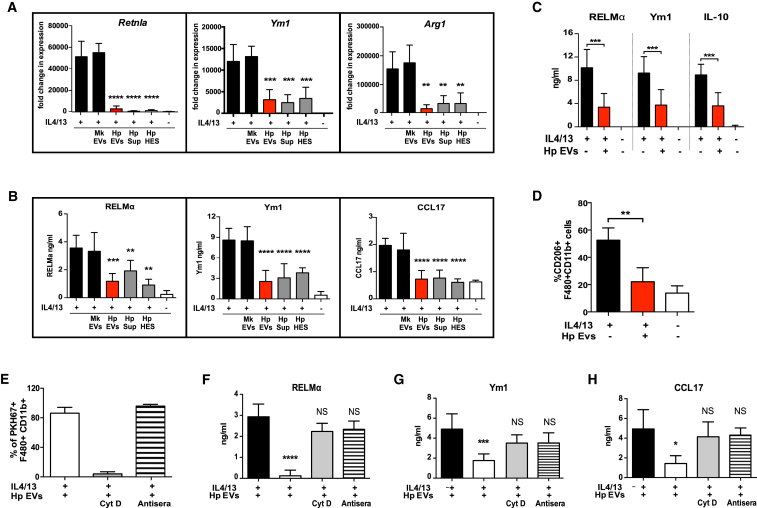
H. polygyrus EVs Suppress the Onset of Alternative Activation in Macrophages(A and B) Relative expression of (A) markers of alternative activation Retnla, Ym1, and Arg1 based on qRT-PCR analysis of extracted RNA or levels of (B) RELMα, Ym1, and CCL17 proteins measured by ELISA from BMDMs treated with 20 ng/mL IL-4/IL-13 ± 5 μg/mL EVs, EV-depleted HES (sup), or total HES (HES) or media alone for 24 hr. As a comparison, cells were incubated with 5 μg/mL EVs derived from MODE-K cells (MK).(C and D) The levels of (C) RELMα, Ym1, and IL-10 by ELISA and expression of (D) CD206 by flow cytometry in BMDMs that were pre-treated with IL-4/IL-13 for 24 hr prior to the addition of 5 μg/mL EVs.(E–H) Percentage uptake of (E) 2.5 μg PHK67-labeled EVs was determined by flow cytometry, and levels of (F) RELMα, (G) Ym1, and (H) CCL17 in the supernatant were assayed from BMDMs co-treated with IL-4/IL-13 and EVs ± 2 μg/mL cytochalasin D or EV antisera (1:2,000) for 24 hr. All data are pooled from two to three independent experiments and presented as mean values ± SD (n = 5–9; one-way ANOVA, ∗p < 0.05, ∗∗p < 0.01, ∗∗∗p < 0.001, and ∗∗∗∗p < 0.0001; NS, not significant).